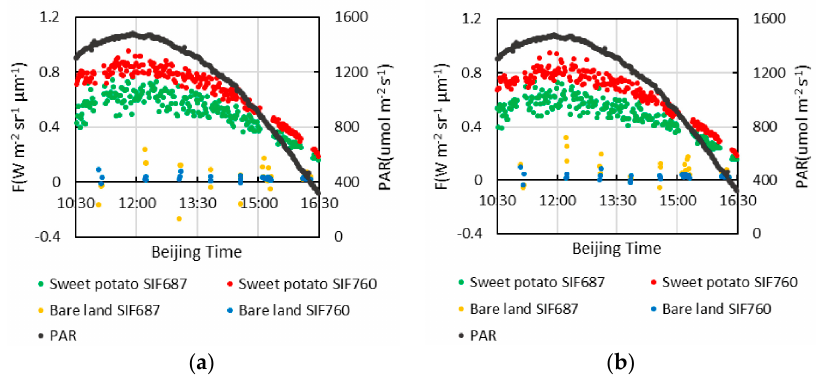
Figure 10. The diurnal variation in SIF at 687 nm and 760 nm of sweet potato and bare land extracted by 3FLD and SFM and the diurnal variation in PAR; ( a ) fluorescence extracted by 3FLD; ( b ) fluorescence extracted by SFM.